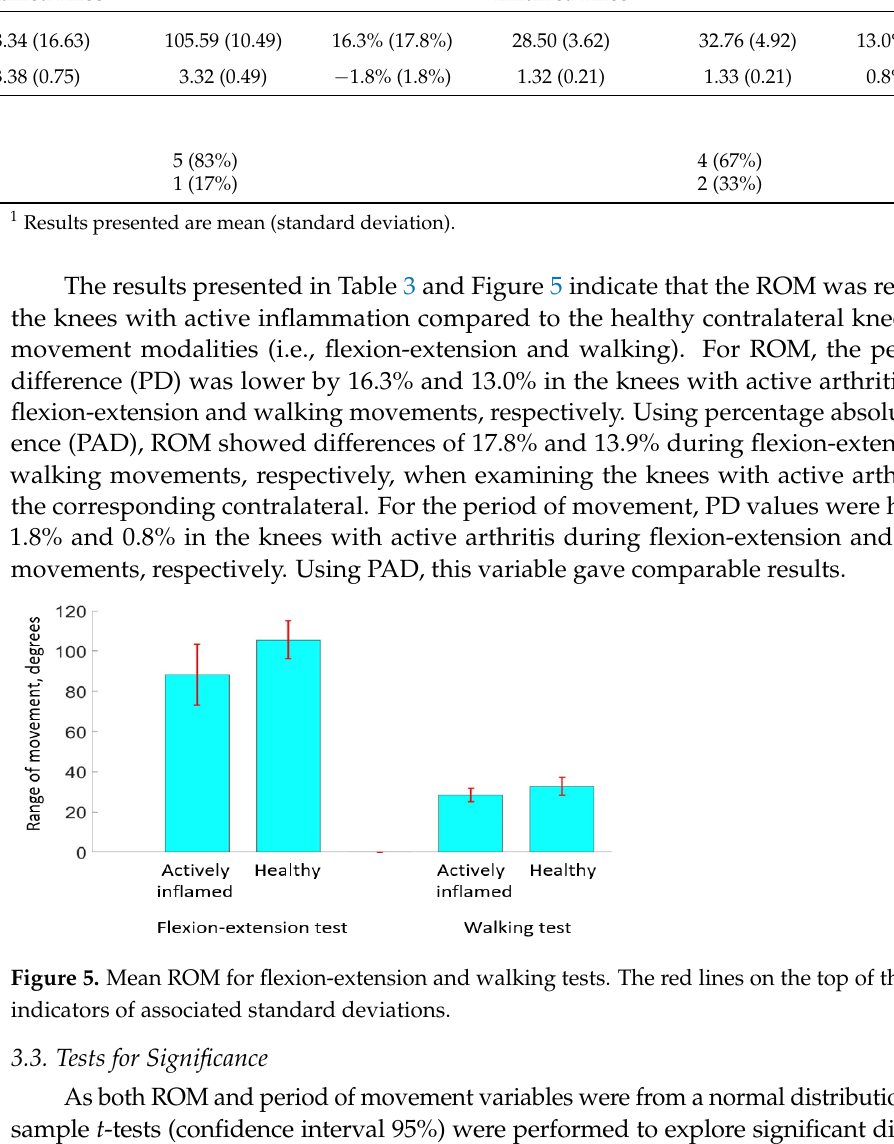
Table 3. Summary statistics for knee range of movement and period of movement, and the concor- dance with pGALS examination findings.